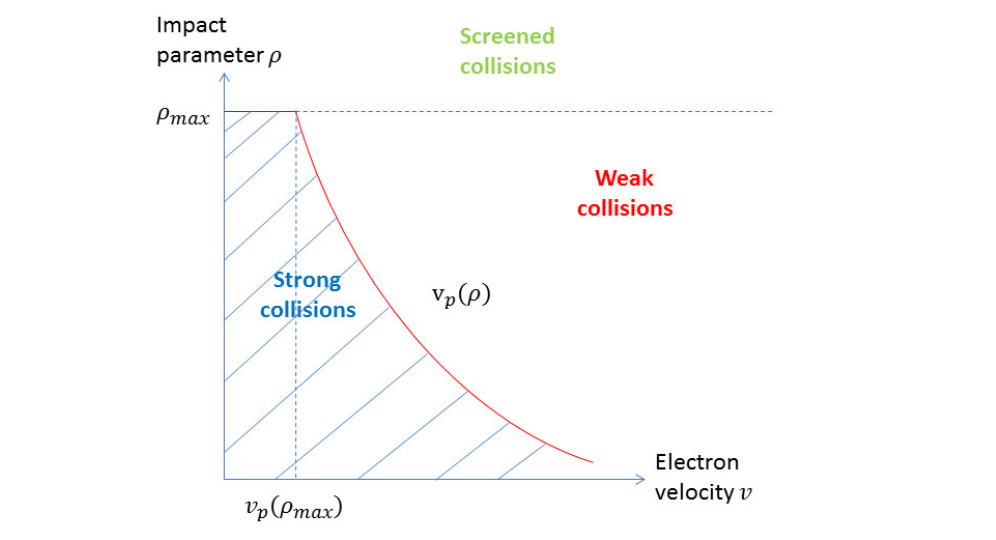
(cid:8) (cid:9) = 1 − S a S † b